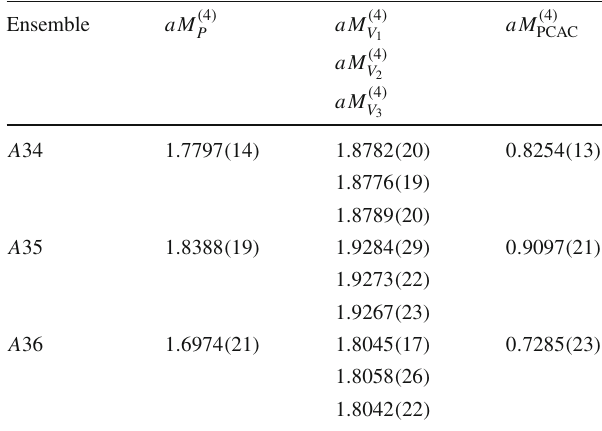
Table 7 Same as in Table 5, but including also meson-like states con- structed from fermions in the sextet representation. We observe that